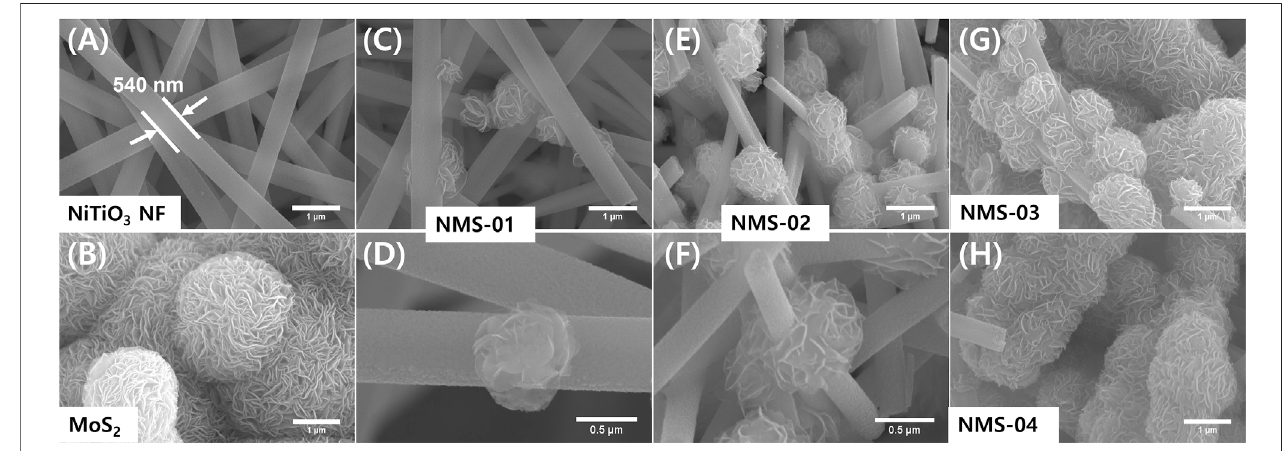
FIGURE 1 | Field-emission electron microscopy images of microstructures. (A) Pristine NiTiO 3 nano fi bers, (B) pristine MoS 2 , (C) low and (D) high magni fi cation images of NMS-01, (E) low and (F) high magni fi cation images of NMS-02, (G) agglomerated MoS 2 in NMS-03, and (H)